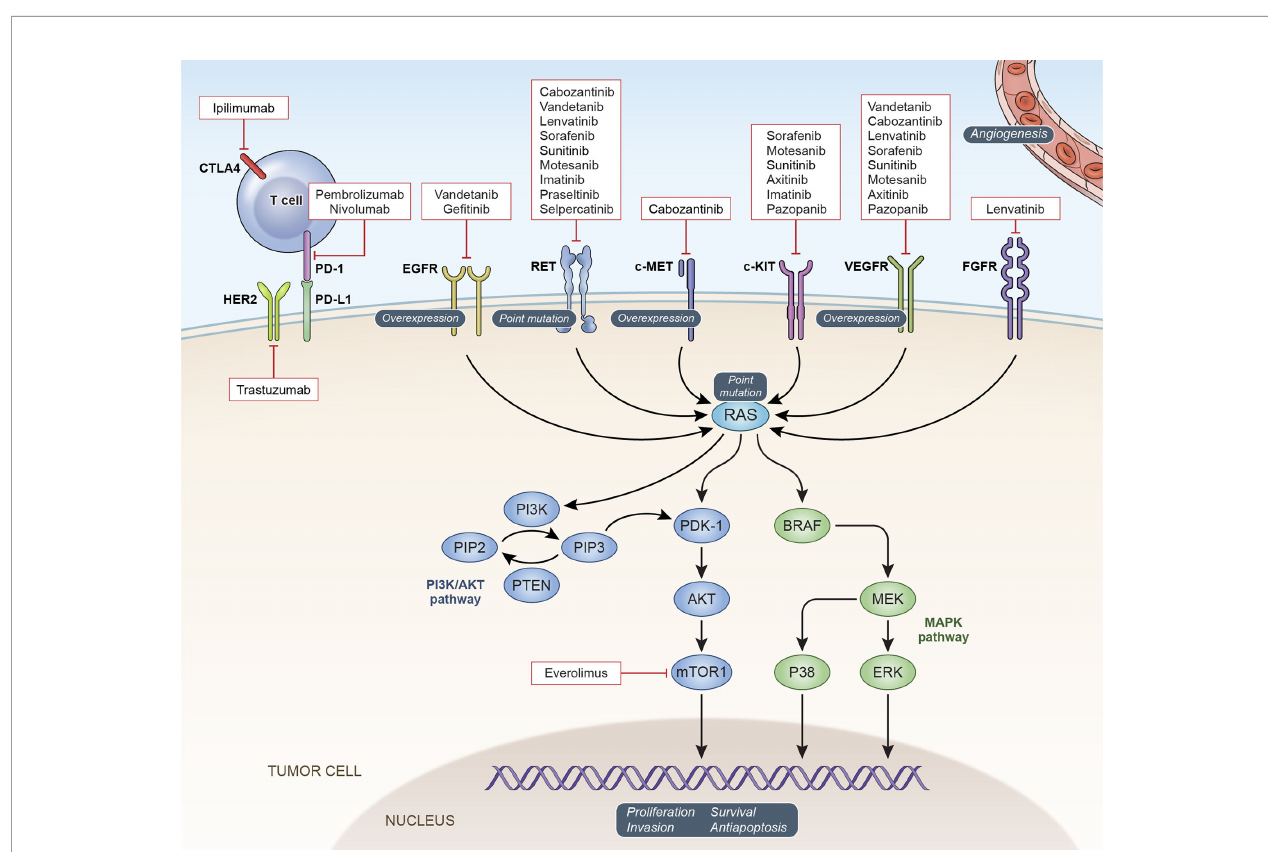
FIGURE 1 | Oncogenic Signaling Pathways in MTC: Potential and con fi rmed therapeutic targets in MTC are depicted with currently available targeted